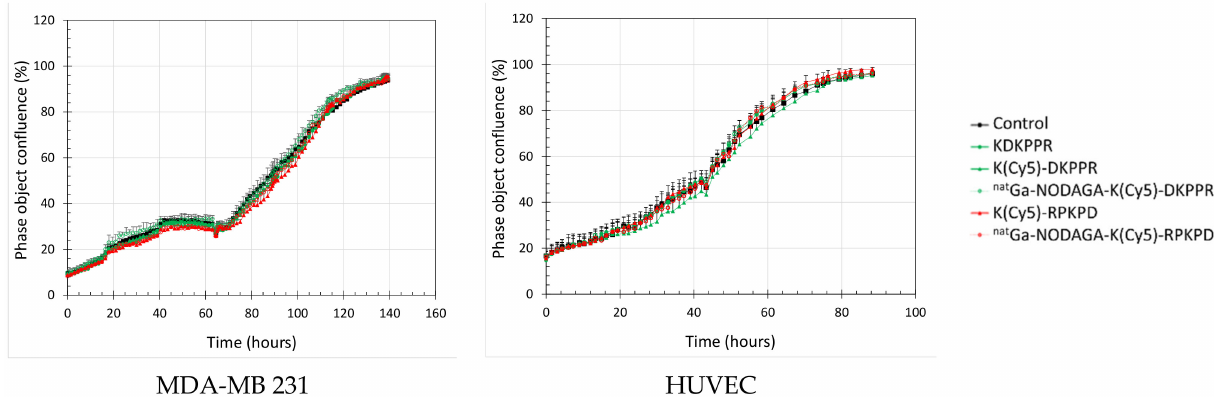
Figure 7. Real-time cell tracking: cell confluence as a function of time. MDA-MB-231 ( left ) or HUVEC ( right ) cells were allowed to grow before being exposed to the culture media (control) (black) or 10 µ M of the NRP-1-targeting (green) or scramble (red) compounds until the end of the experiment: peptide alone (full box, solid line) and nat Ga-NODAGA conjugate (empty box, dotted